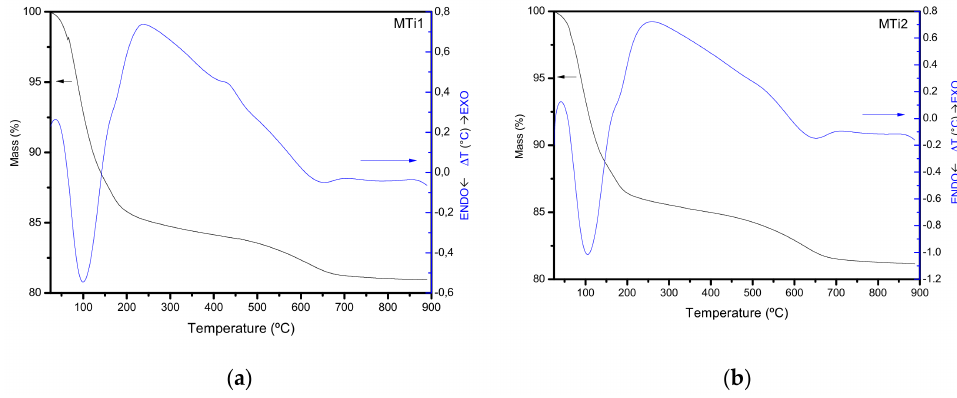
Figure 4. Thermal curves, in oxygen atmosphere, for ( a ) MTi1 and ( b ) MTi2